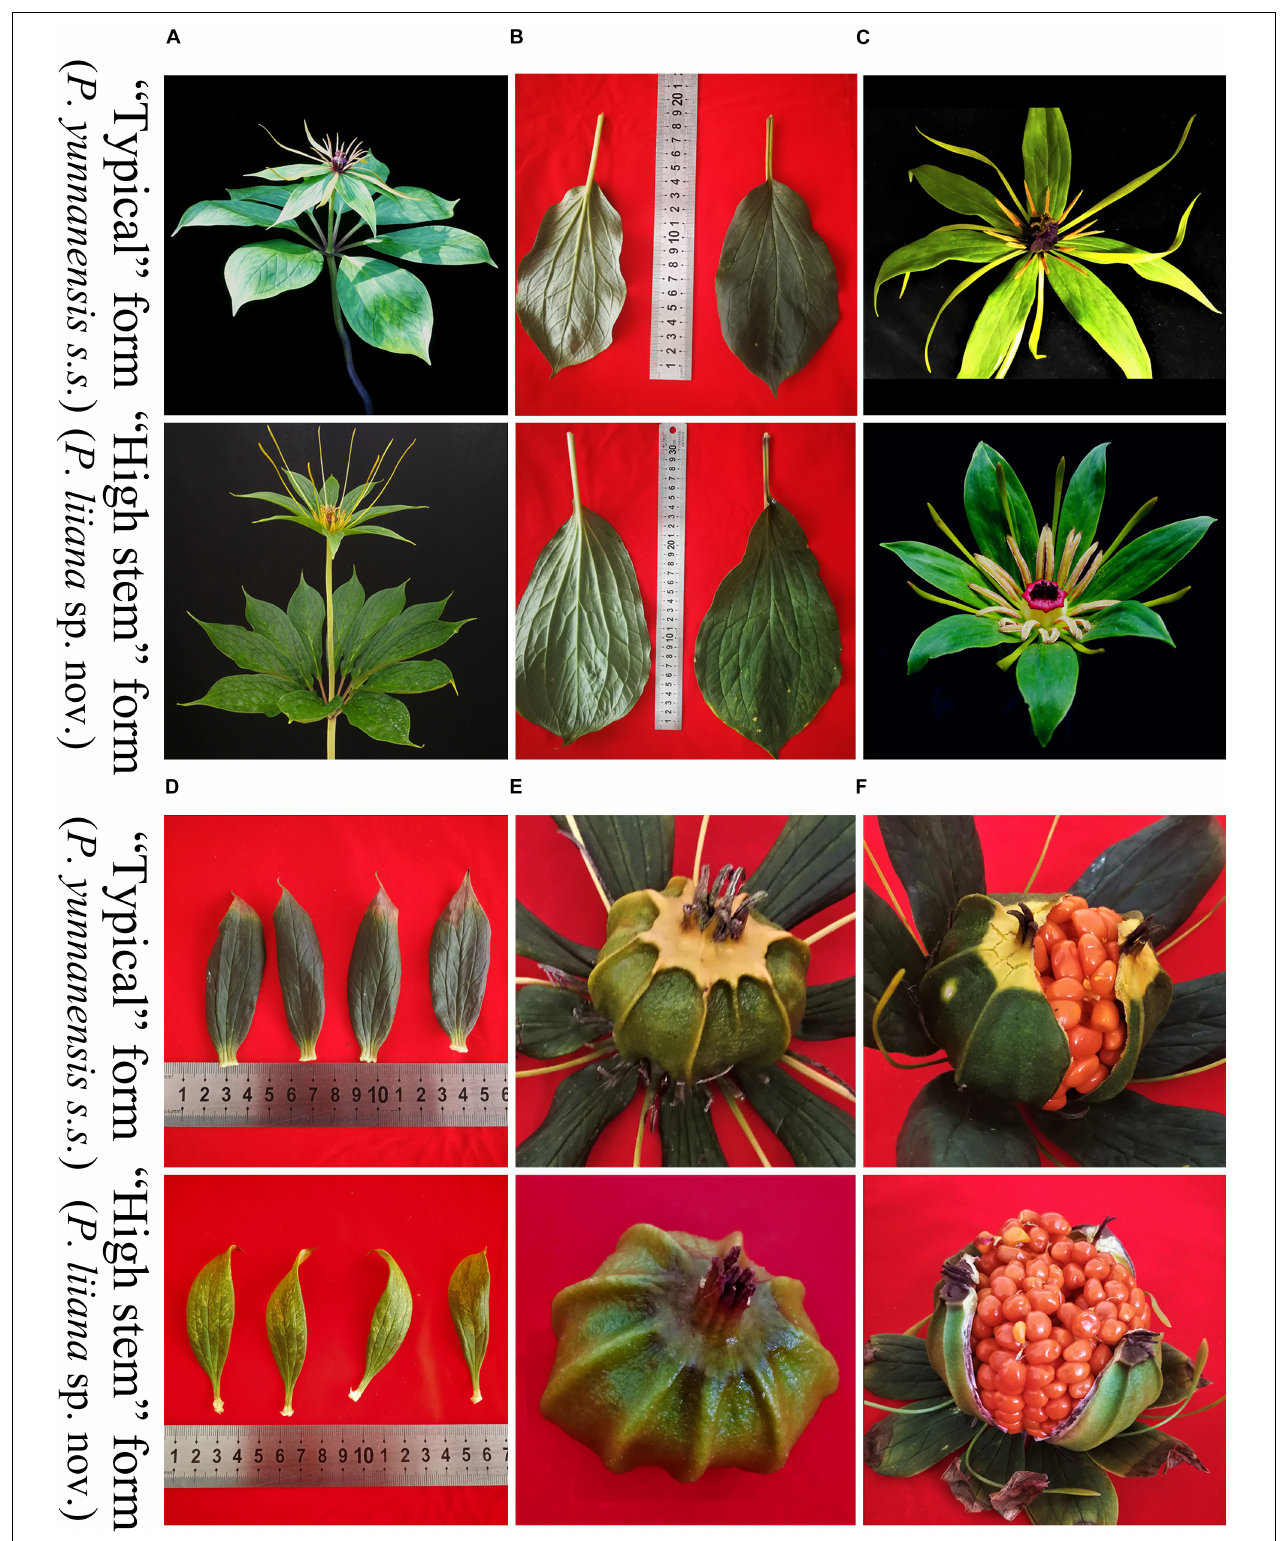
FIGURE 1 | Comparison of morphological features between “typical” Paris yunnanensis ( P. yunnanensis s.s. ) and “high stem” form ( P. liiana sp. nov.). (A) aerial shoot. (B) leaf shape and size. (C) flower. (D) sepals. (E) young fruit. (F) mature fruit.